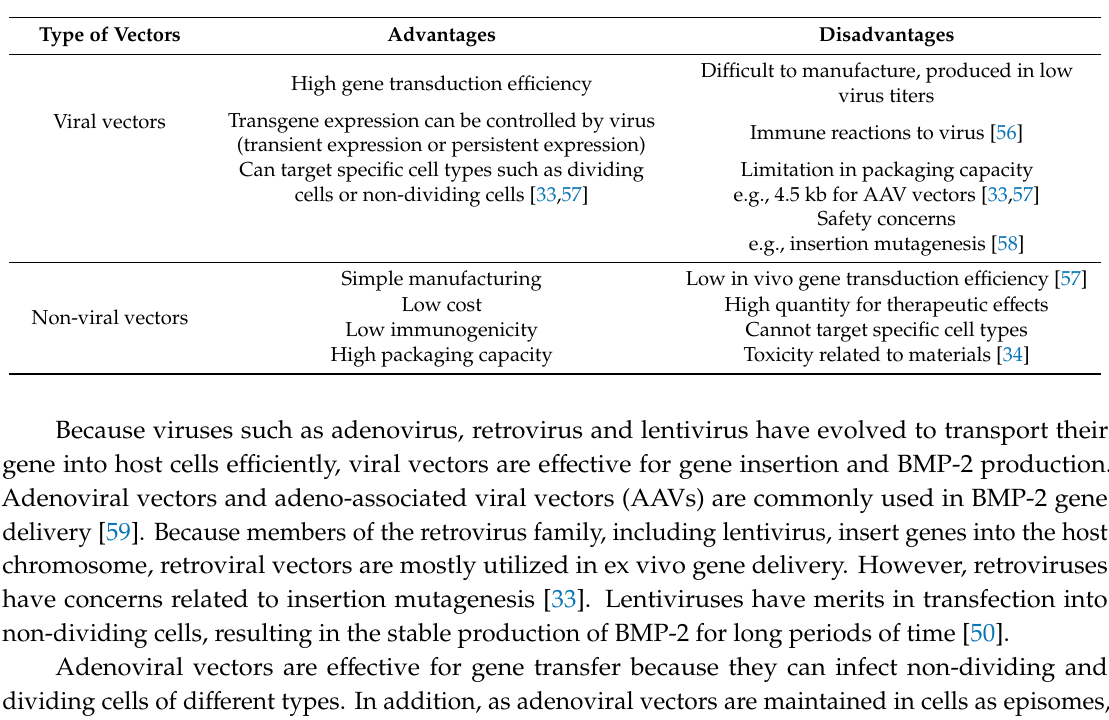
Table 2. Advantages and disadvantages of viral and non-viral vectors in gene